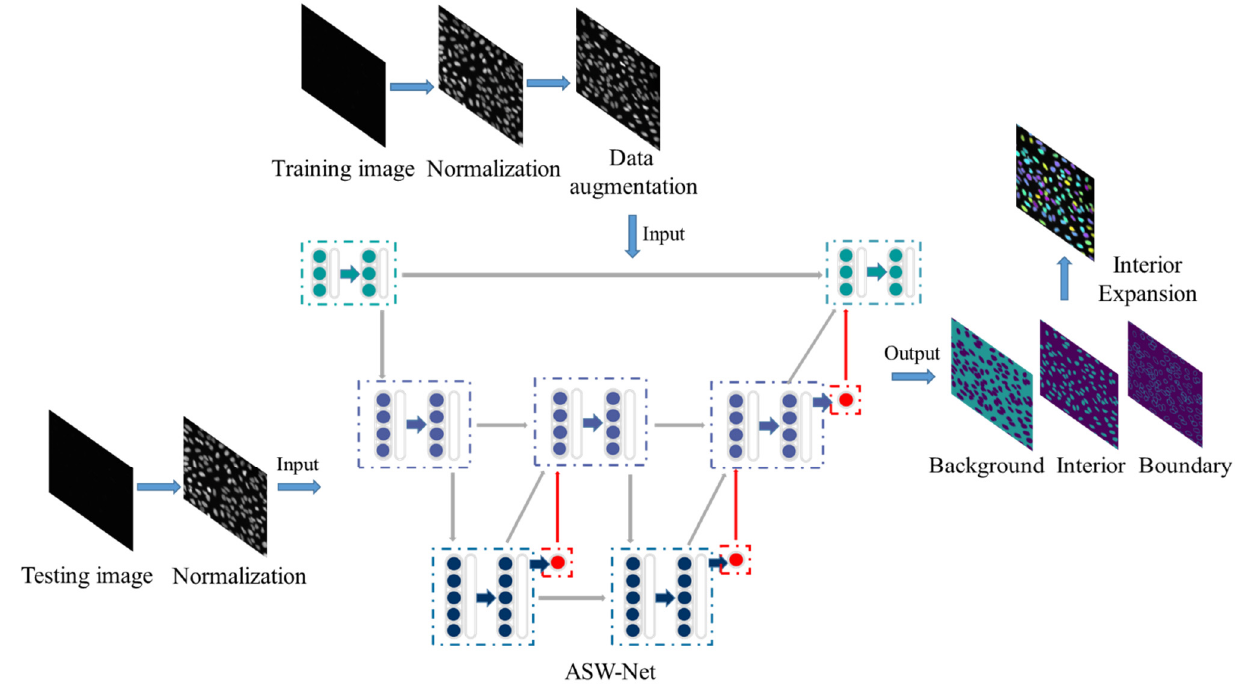
Figure 1. Overview of the proposed framework for nuclear instance segmentation. This pipeline contains image pre-processing, network architecture, and image post-processing. ASW-NET is trained based on the training images, and appropriate weights are found in the training process. In the testing process, the ASW-NET predicts the probability of each pixel’s background, interior, and boundary. Then an interior expansion algorithm is adopted to obtain the final instance segmentation results. The details of ASW-Net are explained in Figure 2.